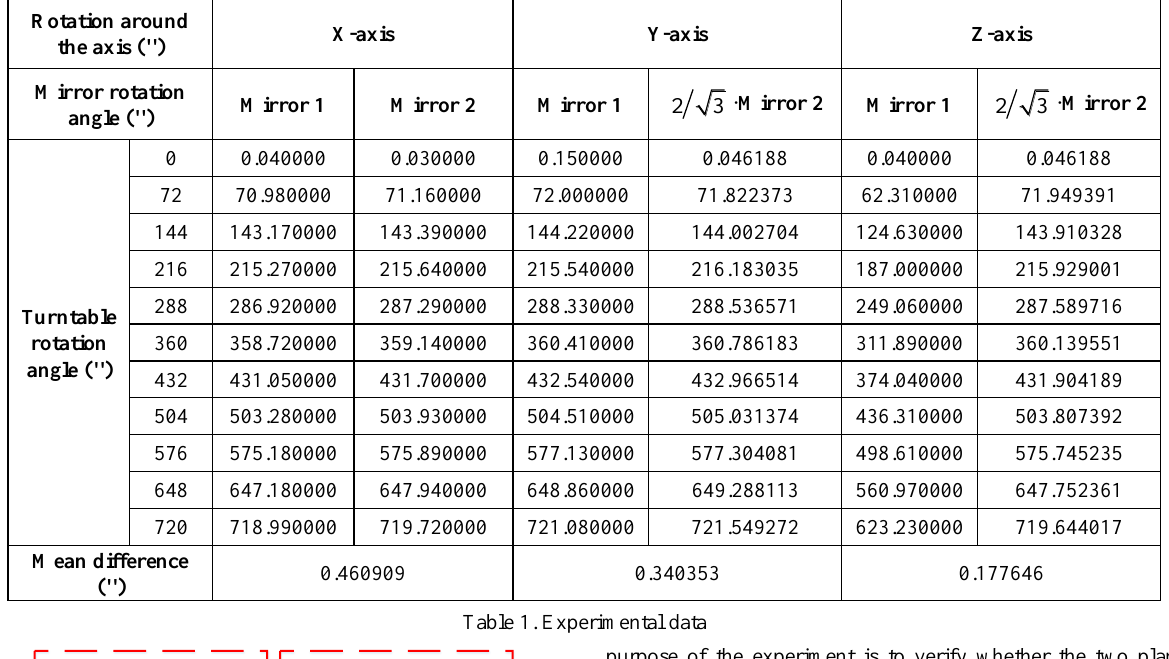
Table 1. Experimental data